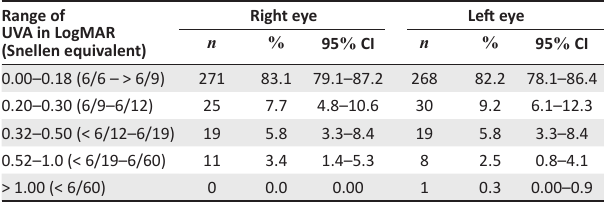
TABLE 4: Distribution of uncorrected visual acuity in logarithm of the minimum angle of resolution for right and left eyes. Range of UVA in LogMAR (Snellen